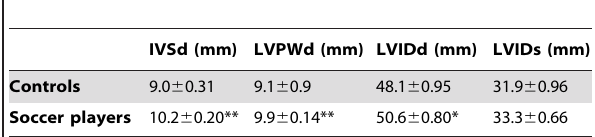
Table 1. Echocardiographic parameters in professional soccer players and age matched controls.